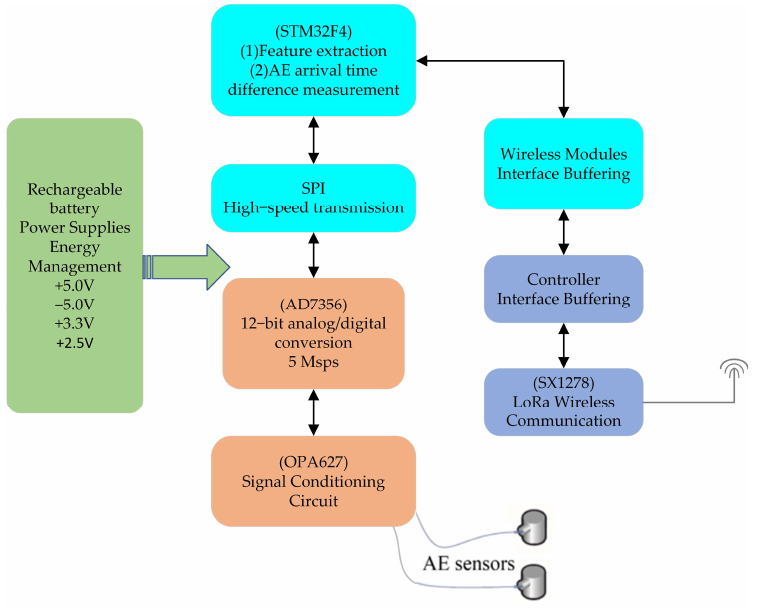
Figure 2. Framework of wireless AE node composition.